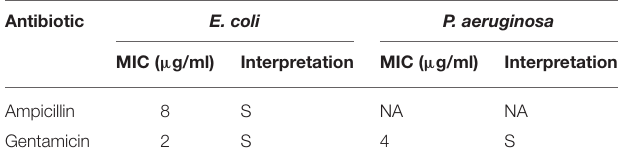
TABLE 3 | The MIC values of selected antibiotics tested against E. coli and P. aeruginosa . Antibiotic E. coli P. aeruginosa Interpretation